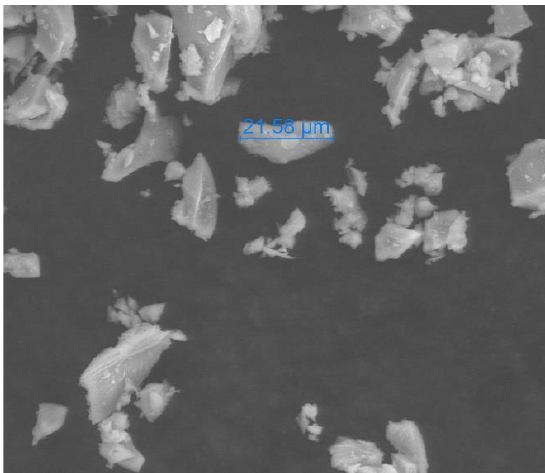
Figure 2. Physical properties of PCMs (PureTemp LLC.).